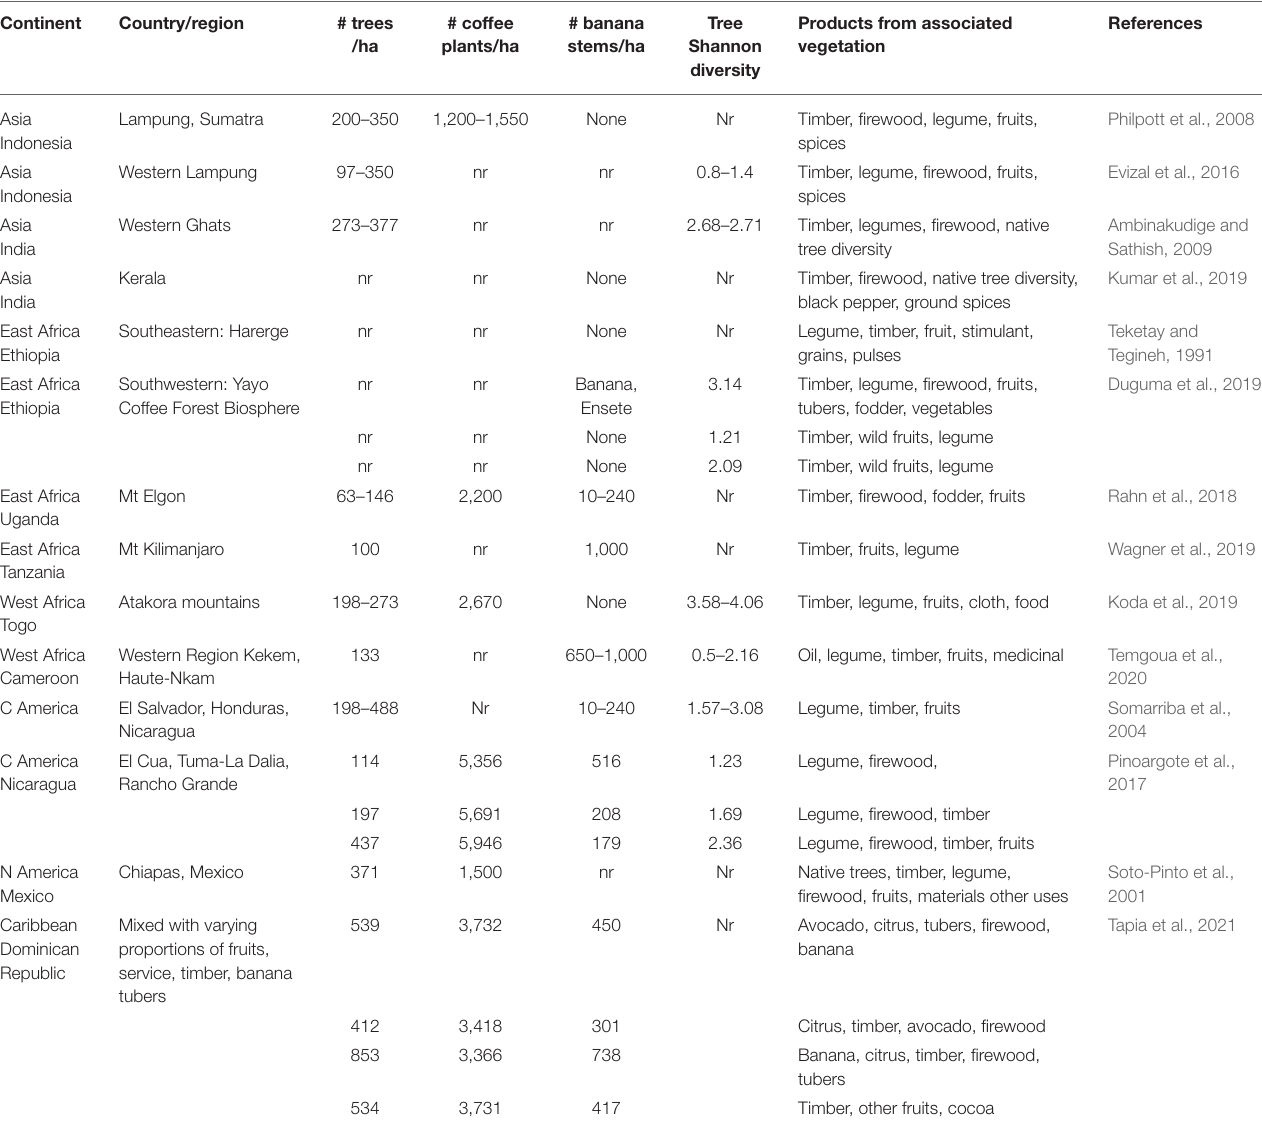
TABLE 1 | Selected parameters from studies of smallholder coffee multi-strata diversity in four continents (nr, not reported by authors). Continent Country/region # trees